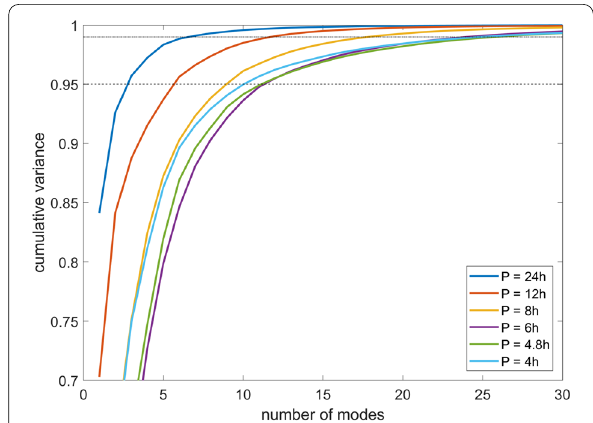
Fig. 4 Cumulative variance for the first 30 spatial modes of PCA applied to the whole 338 days TIE-GCM time series and plotted for each period, P 24, 12, 8, 6, 4.8, and 4 h. FT segment length is 24 h. = Dashed and dash-dotted lines mark the 95% and 99% thresholds,